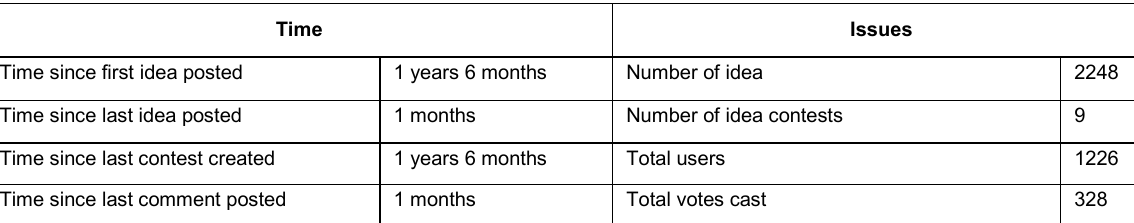
Table 1. Detailed data of the idea collection